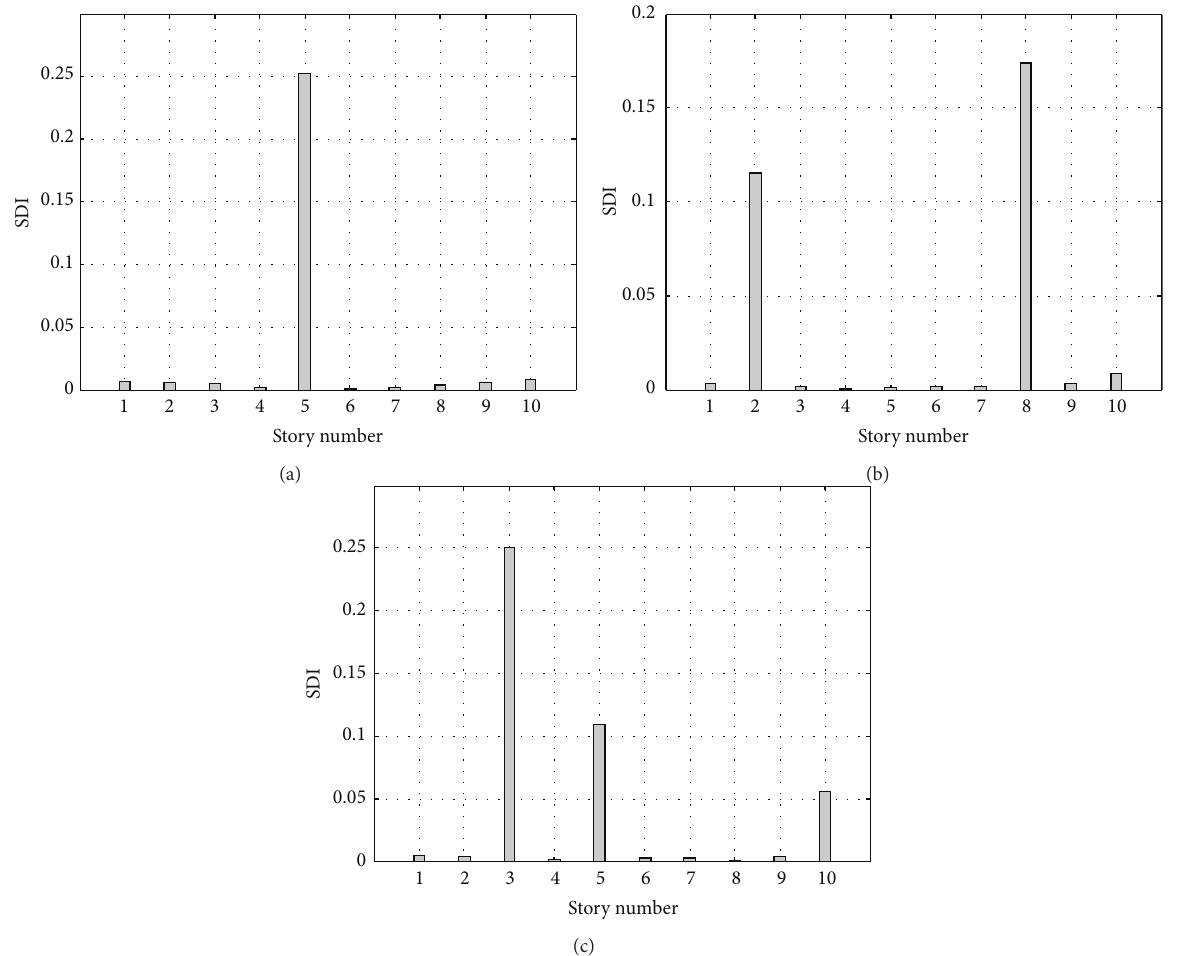
Figure 8: (a) Value of SDI in the ten-story shear frame considering 3 modes for scenario I, (b) value of SDI in the ten-story shear frame considering 3 modes for scenario II, and (c) value of SDI in the ten-story shear frame considering 3 modes for scenario III. 00.050.10.150.20.25